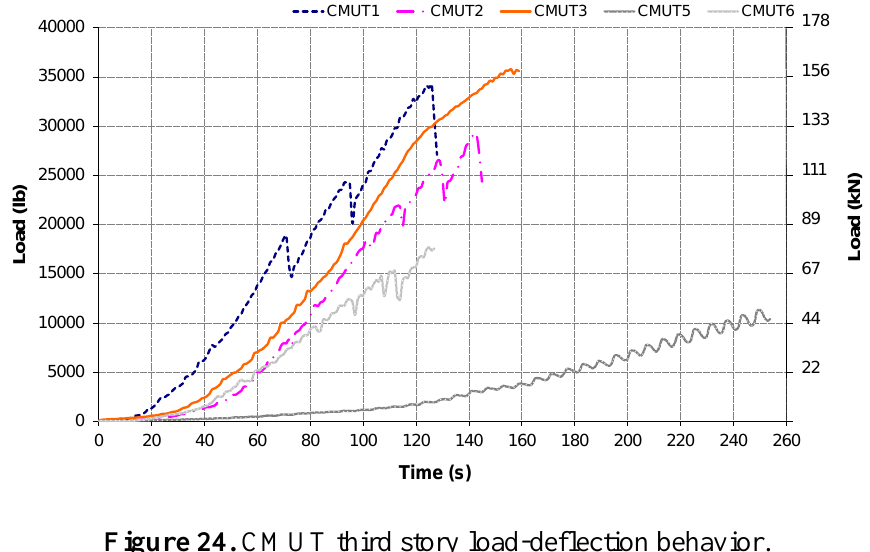
Figure 24. CMUT third story load-deflection